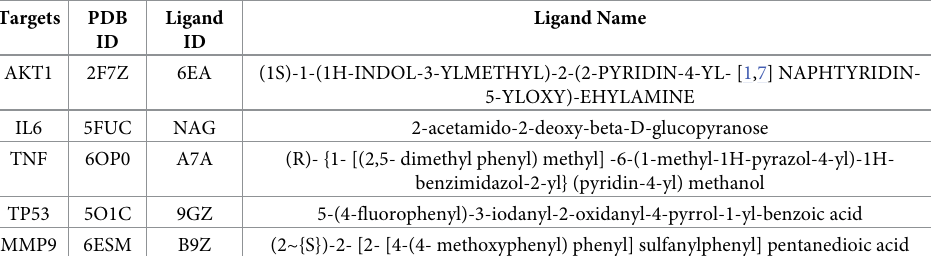
Table 2. The basic information of ligand and